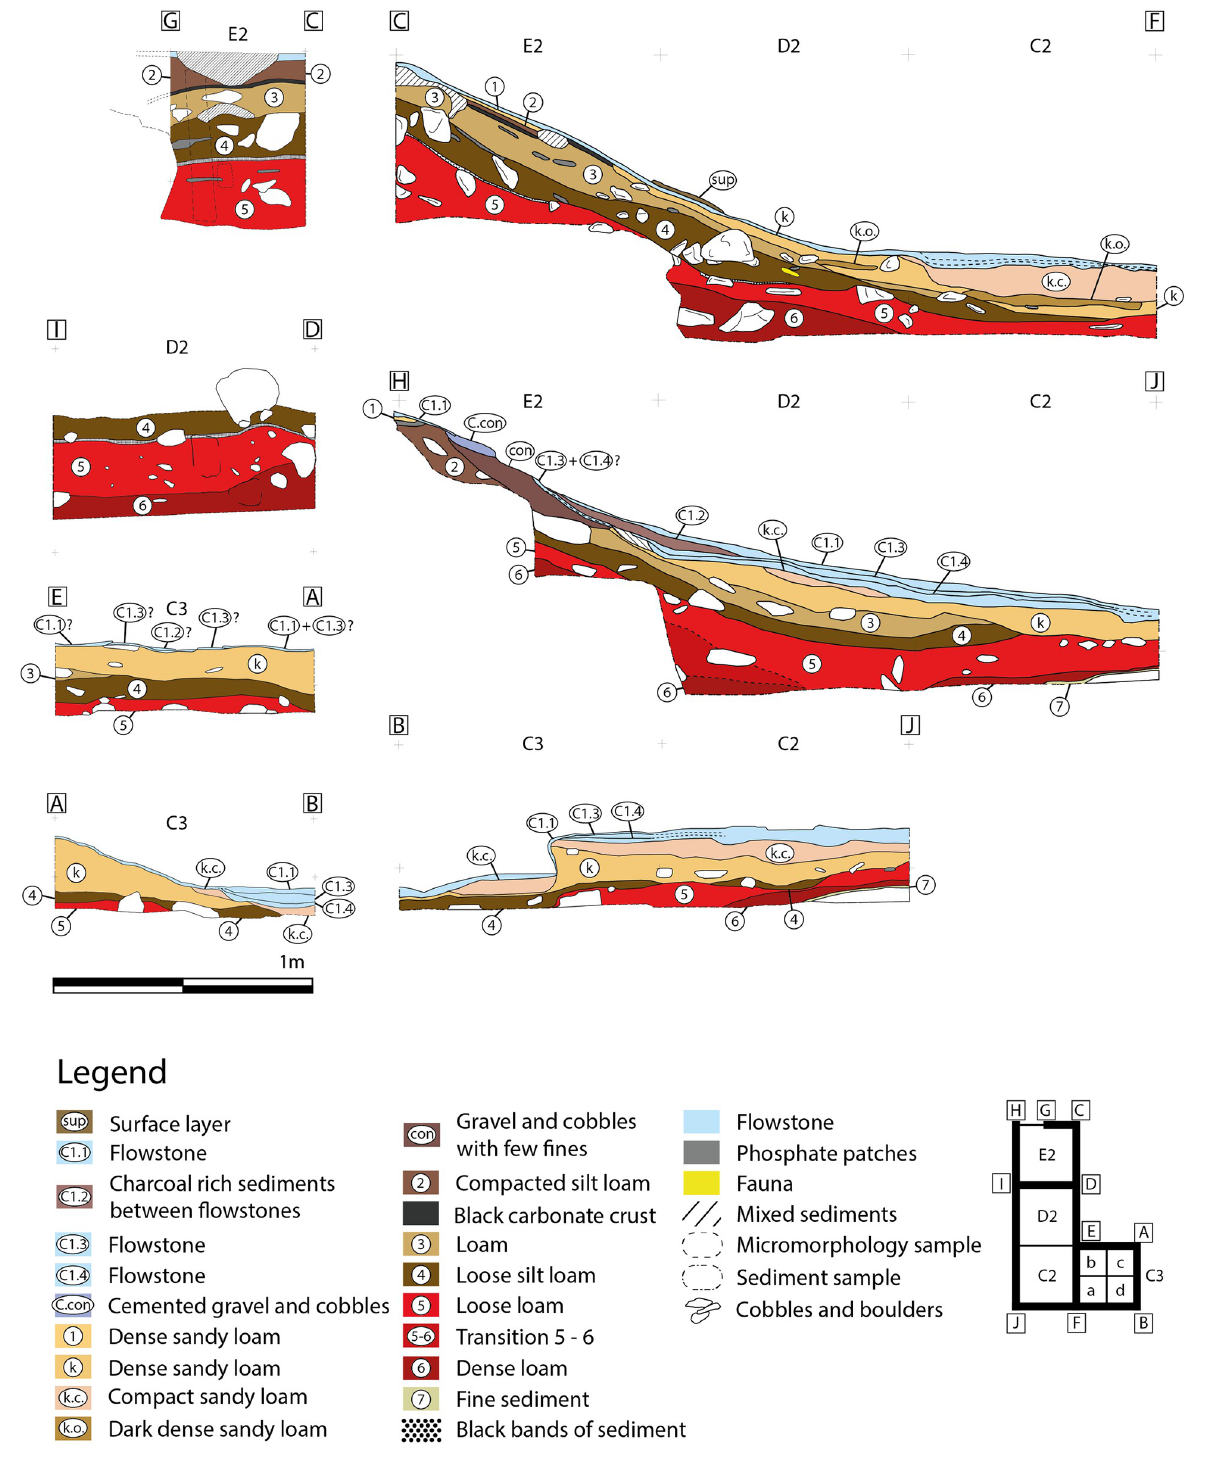
Fig 13. Sections in zone